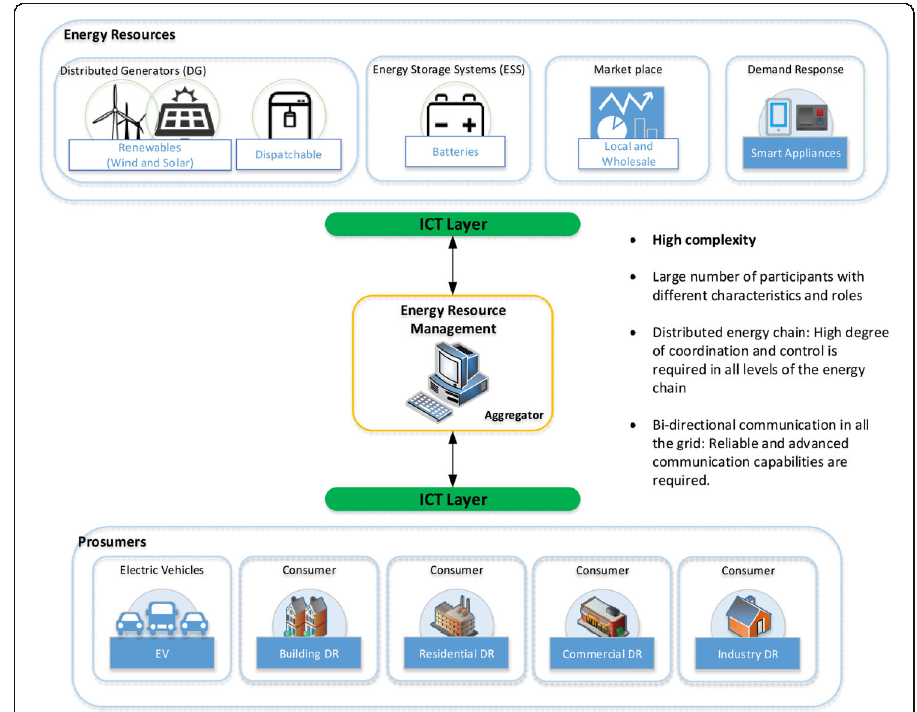
Fig. 2 General overview of the platform